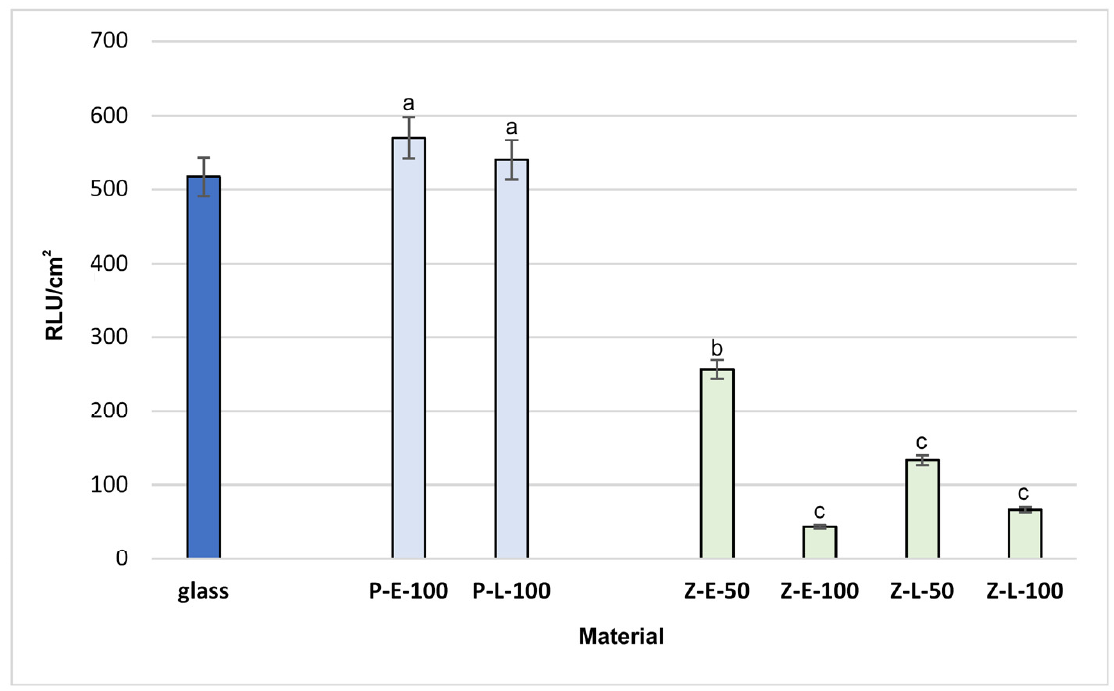
Figure 9. Adhesion of Aeromonas hydrophila to glass (control) and the functionalized silicones. The results were compared to those for the control glass carrier. Values with letters show statistically significant differences: a, p ≥ 0.05; b, 0.005 < p < 0.05; c, p < 0.005.